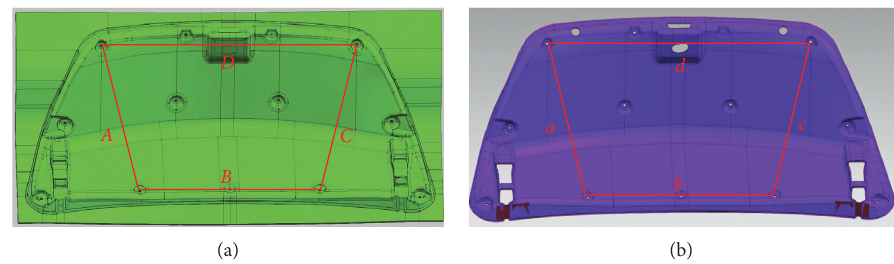
Figure 17: Trunk trim panel and shrinkage measuring